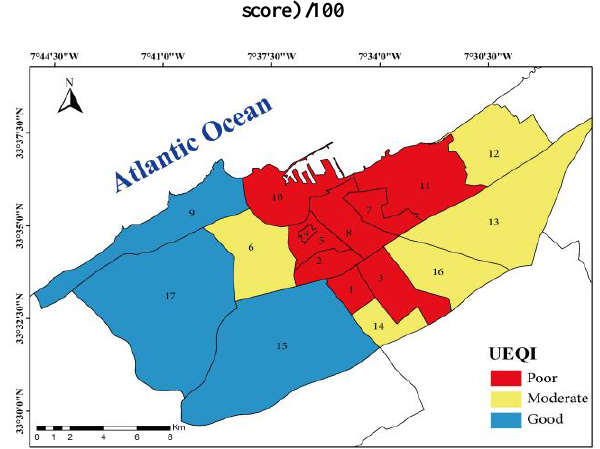
Figure 4 . The Urban Environment Quality Index of the 17 communes of Casablanca